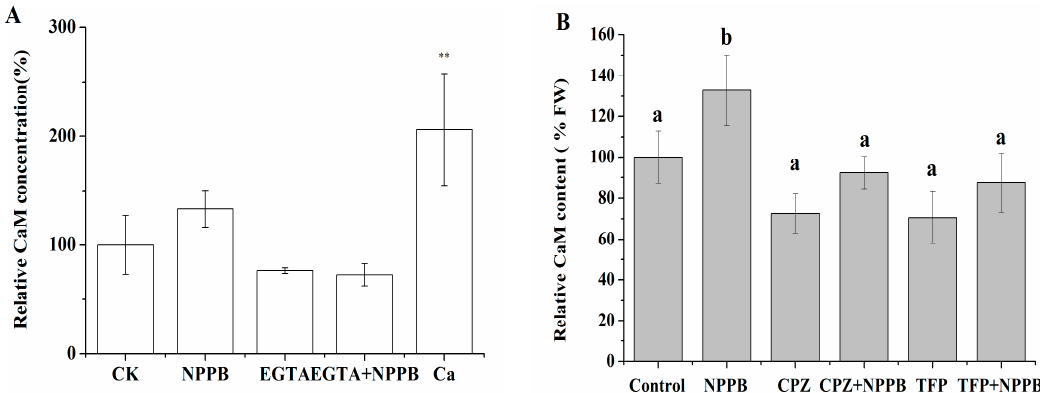
Figure 5. Effect of Ca 2+ chelator (EGTA) and CaM antagonists (CPZ and TFP) pre-treatment on CaM levels in NPPB-treated tea roots, respectively. ( A ) Control, NPPB, EGTA and Ca 2+ indicate the application of distilled water, 50 µM NPPB, 1 mM EGTA and 1 mM Ca 2+ for 2 h, respectively; EGTA + NPPB refers to tea roots were placed in 1 mM EGTA for 0.5 h, then directly subjected to 50 µM NPPB for 2 h; ( B ) Control, NPPB and CPZ, TFP indicate distilled water, 50 µM NPPB and 50 µM CPZ or TFP for 2 h, respectively; CPZ + NPPB and TFP + NPPB refer to tea roots were placed in 50 µM CPZ and TFP for 0.5 h respectively, then subjected to a direct 50 µM NPPB for 2 h. CaM level was detected after control, NPPB and CPZ, TFP, CPZ + NPPB and TFP + NPPB treatment in tea roots. Data indicate mean ± SD ( n = 4). Error bars indicate differences among the treatments and different low case numbers near the chart bars indicate the level of significance as compared with control at p < 0.05; Note: The data for Ca 2+ treatment was adapted from [31].